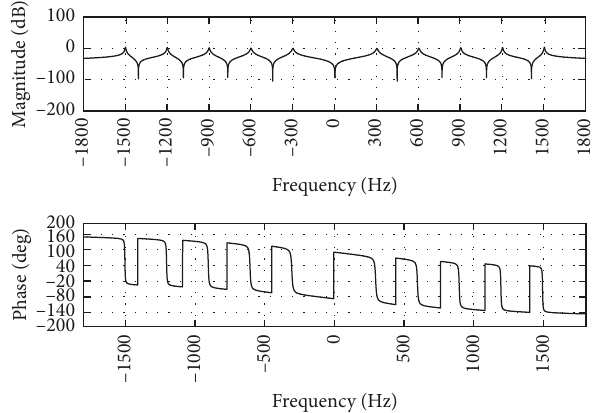
Figure 8: Bode diagram of closed loop current considering digital control